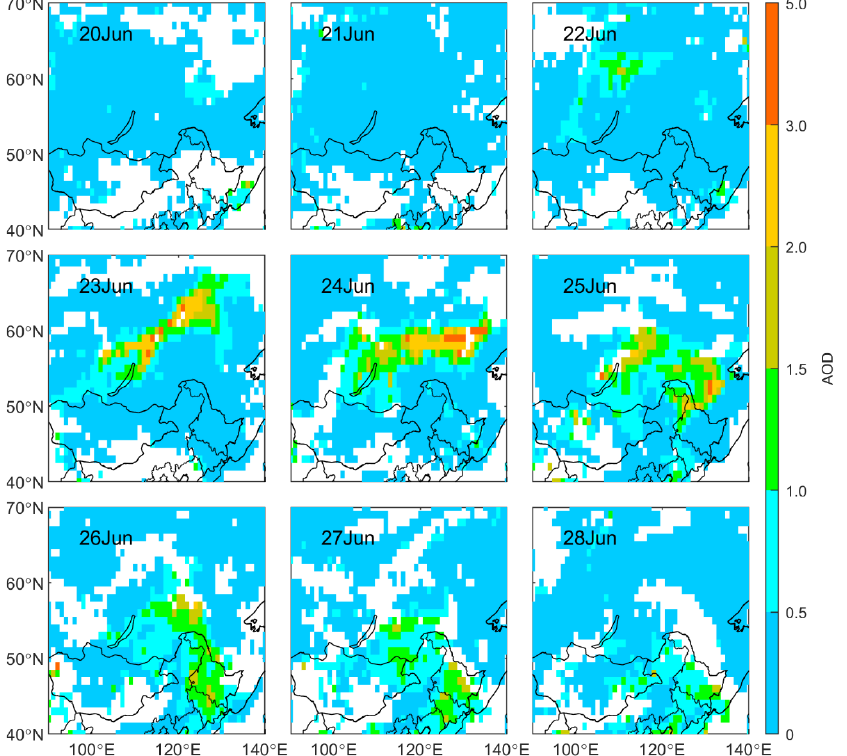
Figure 7. Spatial distribution of AOD monitored by Aqua MODIS from 20 June to 28 June 2017 in Northeast Asia. In order to explore the impact of the BB plume on aerosol optical properties, the UVAI measured by OMI during the episode was analyzed. It is used to indicate the degree of aerosol absorption by solar radiation in the ultraviolet band, and it is more sensitive to ultraviolet-absorbing aerosols [32]. The UVAI of absorbing aerosols, such as smoke and mineral dust, is positive, and a small or even negative value represents nonabsorbent aer- osols (e.g., sulfates, sea salt, etc.) and clouds [38]. As shown in Figure 6c, the daily mean values of UVAI were low in Siberia before 22 June at ~0.1, indicating the weak absorption of particles in Siberia. With the intensification of the BB and the accumulation of carbona- ceous aerosols, the UVAI value in the burning area and its vicinity increased significantly after 22 June, with the highest value reaching 9.5 on 23 June (Figure 8). The daily mean UVAI in Siberia also reached a peak on 24 June of more than six times the daily mean values before 22 June. For the UVAI in Northeast China, the daily mean UVAI was nega- tive at ~ − 0.1 in Northeast China before the smoky plume’s arrival . The UVAI value in the northern and northeastern regions of Heilongjiang Province rose rapidly from 0.5 to over 2.0 on 25 June, with a maximum of 4.3. After that, the smoke was transported all the way to the south to the Jilin and northern Liaoning provinces. The daily mean UVAI in North- east China reached a peak of 1.3 on 26 June and subsequently dropped sharply. The drop can be attributed to the retrieval failure of UVAI in the plume-affected area and the aging of the plume.